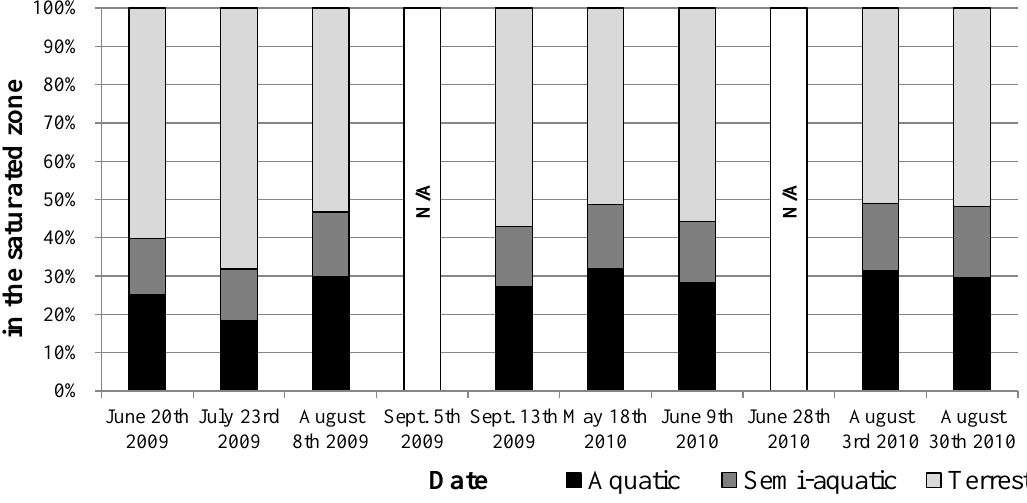
Figure 7. Aquatic, semi-aquatic, and terrestrial proportions of the site 1 saturated zone for each GeoEye-1 image acquisition date. The term N/A refers to missing data due to the presence of clouds over site 1.